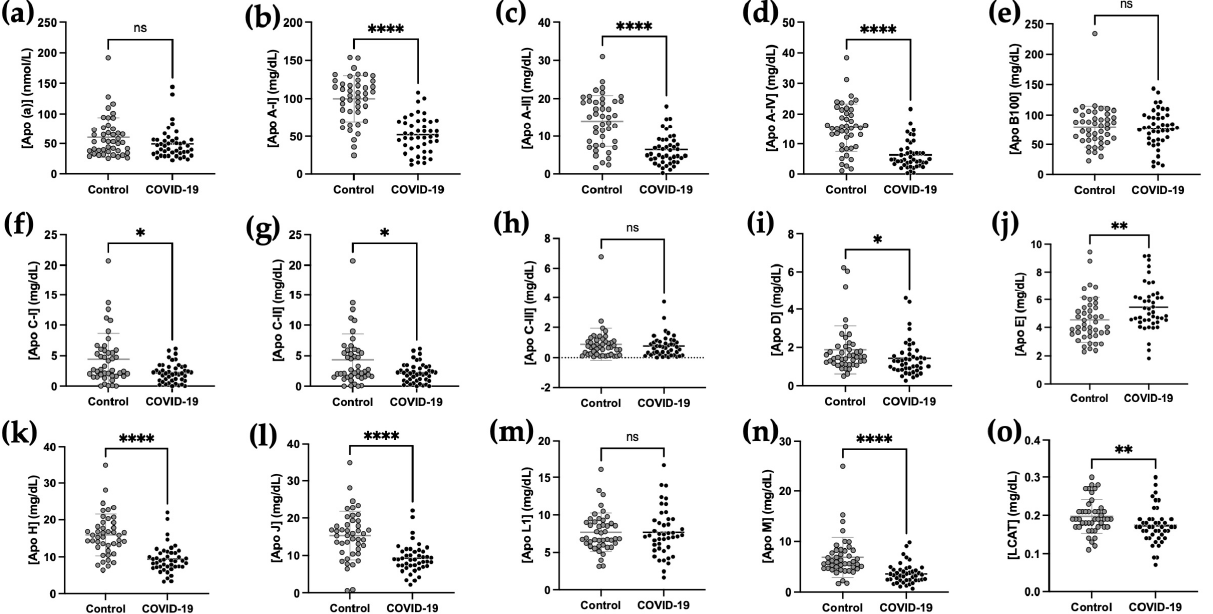
Figure 2. Changes in apolipoprotein and LCAT levels in plasma of COVID-19 ICU patients. Fourteen apolipoproteins ( a – n ) and LCAT ( o ) were quantified by mass spectrometry in the plasma of 44 COVID- 19 ICU patients and 44 controls. A Shapiro–Wilk test for normality was performed followed by an unpaired t -test for data with a parametric distribution whereas a Mann–Whitney test was performed for data with a nonparametric distribution. * p < 0.05, ** p < 0.01, **** p < 0.0001, ns p ≥ 0.05 comparing control group and COVID-19